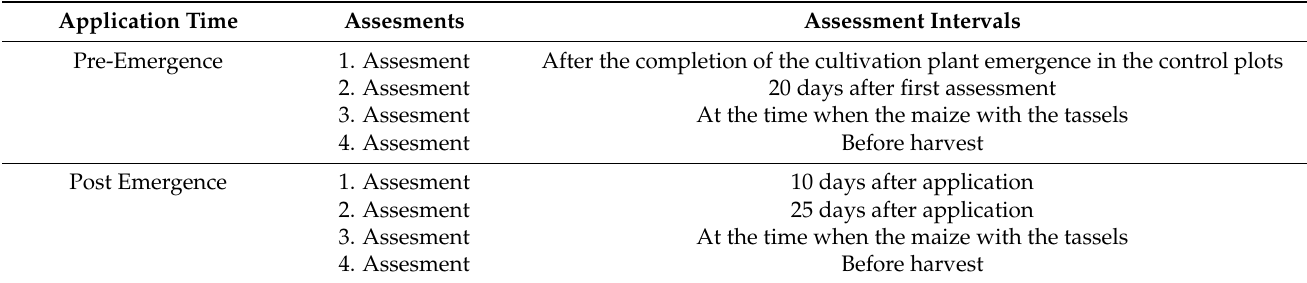
Table 4. Assessment and assessment times corresponding to the herbicide